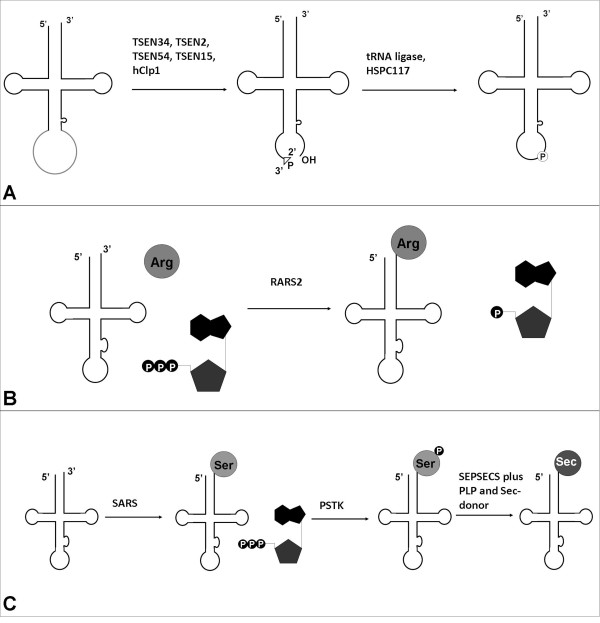
Different RNA processing events in mammals. 2A: Eukaryotic splicing pathway of tRNA splicing in mammals. The TSEN complex is involved in the maturation of premature tRNAs and excises the tRNA into two halves; one 5'tRNA half with a 2'-3' cyclic phosphate at one exon-end and a 3'tRNA half with a 5'OH-group at the other exon-end. The final processing of tRNA maturation involves either direct ligation of the two tRNA halves by ligation through the Archaea-like pathway (by HSPC117, depicted) or indirect ligation through the yeast-like pathway (not depicted) [104]. Adapted from Calvin et al. [105]. 2B: tRNA aminoacylation in mammals. RARS2 can bind to its cognate amino acid in an ATP dependent matter. This complex of ATP, RARS2 and arginine binds to the mt-tRNA-Arg and arginine will be transferred to its tRNA. Adapted from Antonellis et al. [83]. 2C: Selenocysteine synthesis. Serine (Ser) is aminoacylated to tRNA-Sec by a seryl-tRNA synthetase (SARS). This Ser-tRNA-Sec complex is then converted by a kinase to a Sep-tRNA-Sec complex. In the presence of the cofactor pyridoxal phosphate (PLP) and the selenium donor selenophosphate (Se-donor) the SEPSECS enzyme converts the Sep-tRNA-Sec to Sec-tRNA-Sec. Adapted from Allmang et al. [87].